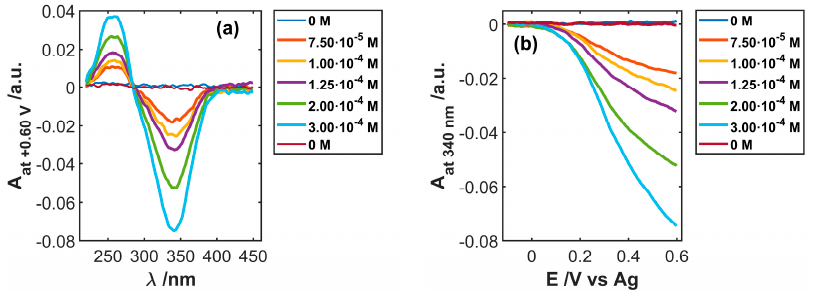
Figure 7. ( a ) Spectra at +0.60 V and ( b ) voltabsorptograms at 340 nm registered during the oxidation of different concentrations of NADH in 0.1 M PBS.